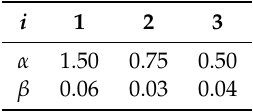
Table 1. Parameters of functions ϕ i ( Y i ) .